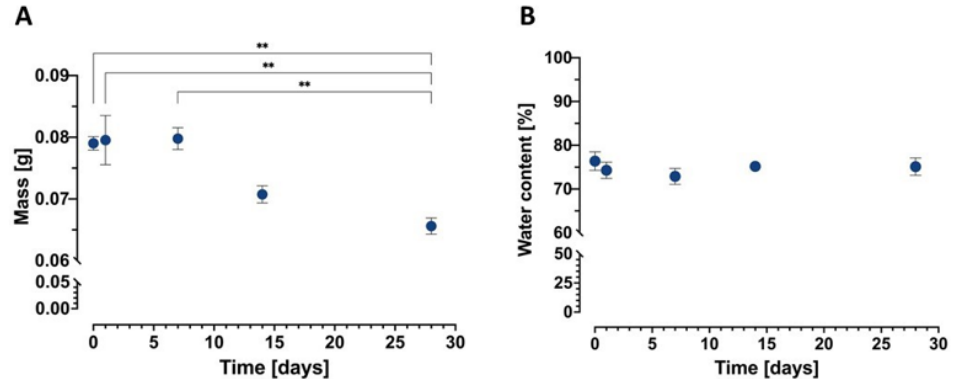
Figure 6. Change in ( A ) mass and ( B ) water content during incubation of CH/NGF-µS/PCL conduits in phosphate-buffered solution (pH 7.4) with lysozyme at 37 °C up to 28 days. Values with statistically significant differences are labeled by asterisks: ** p < 0.005.